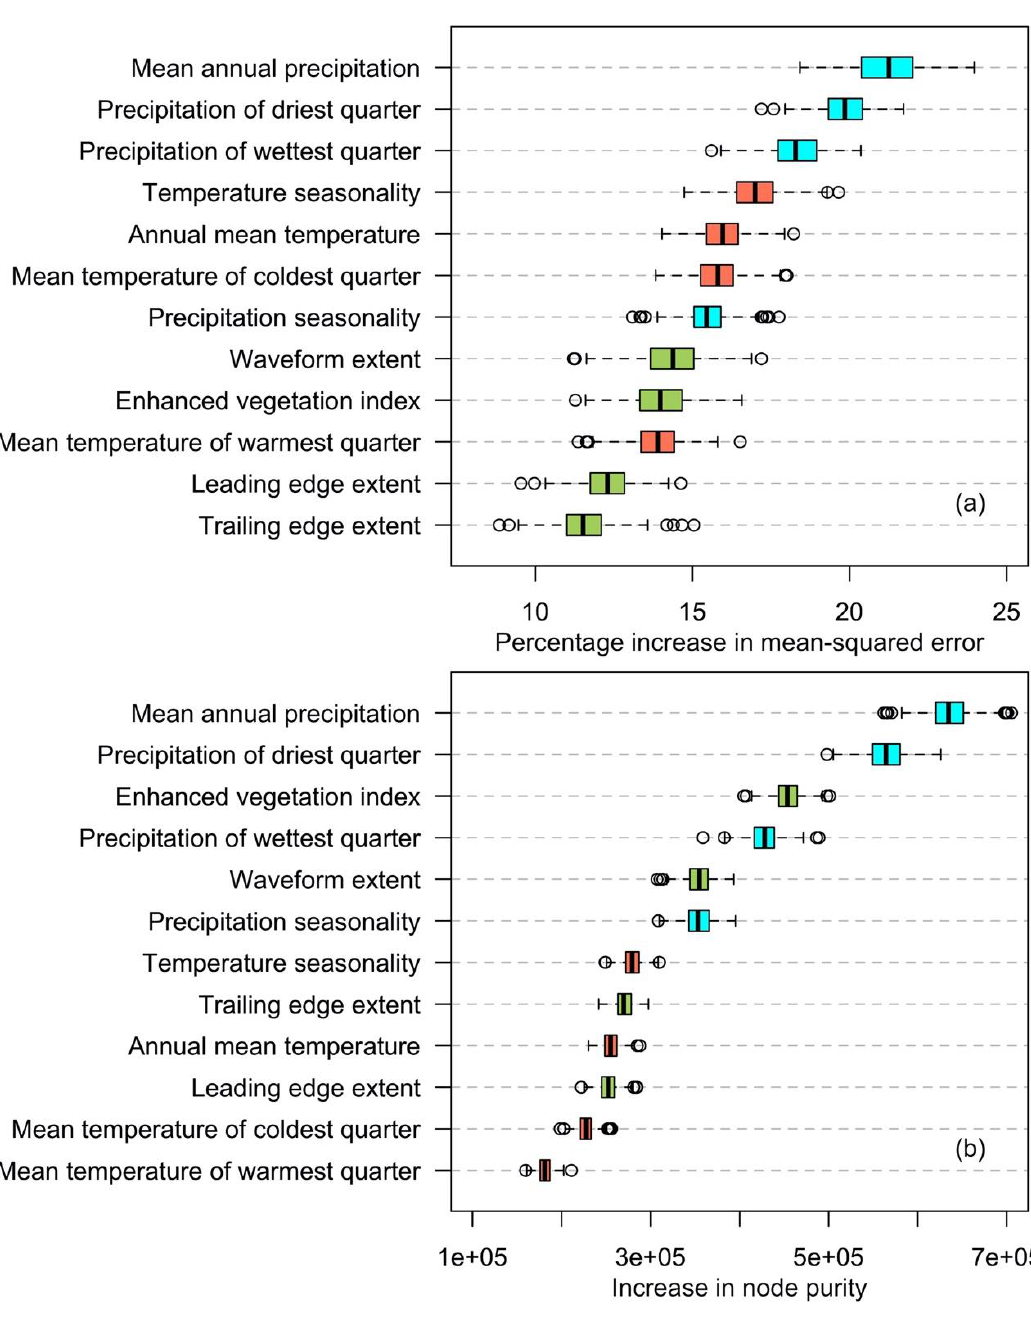
Figure 6. The mean importance of variables for AGB estimation using the randomForest model is indicated by the percentage increase of mean-squared error ( a ) and the increase in node purity ( b ) from highest to lowest. Percentage increase in mean square error is calculated by the increase in mean square error when a variable is removed in the model. The increase in node purity is calculated based on the reduction in sum of squared errors whenever a variable is chosen to split.